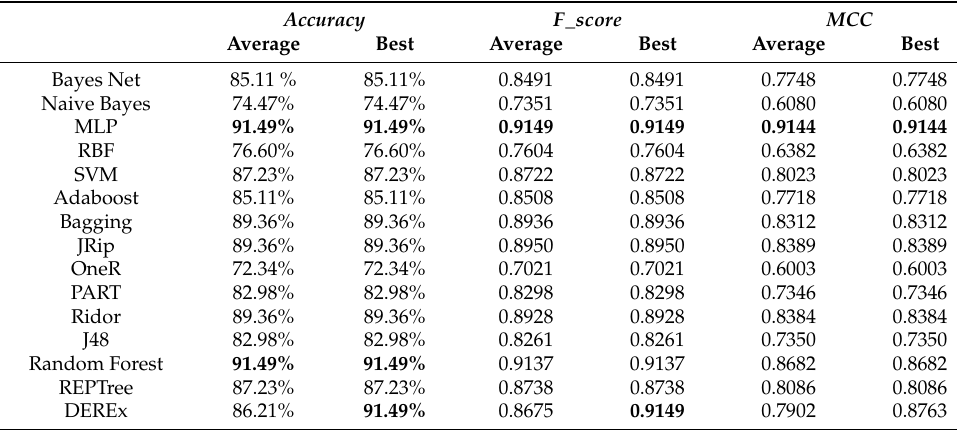
Table 8. The numerical results for the 3-Class